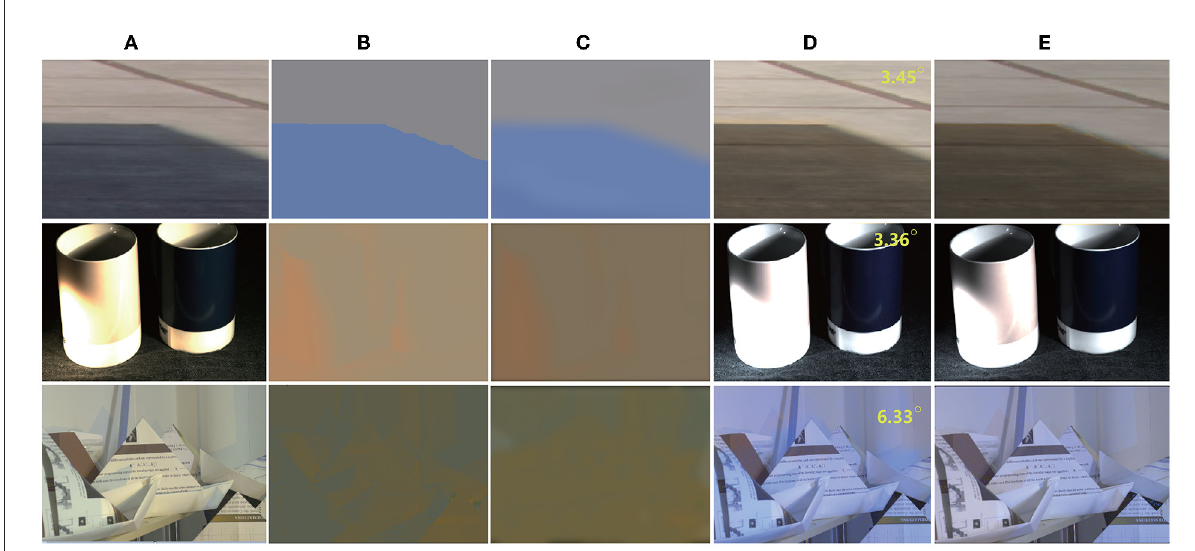
FIGURE4 Qualitative results on MIMO multi-illumination datasets (Beigpour et al., 2014), the top right-hand corner of each image indicates the angle error. From left to right: (A) Original image; (B) Ground truth illumination image; (C) Estimated illumination image; (D) Corrected image; (E) Ground truth image. Dataset available at: http://www5.cs.fau.de/research/data/two-illuminant-dataset-with-computed-ground-truth/. Reproduced with permission from Beigpour et al.